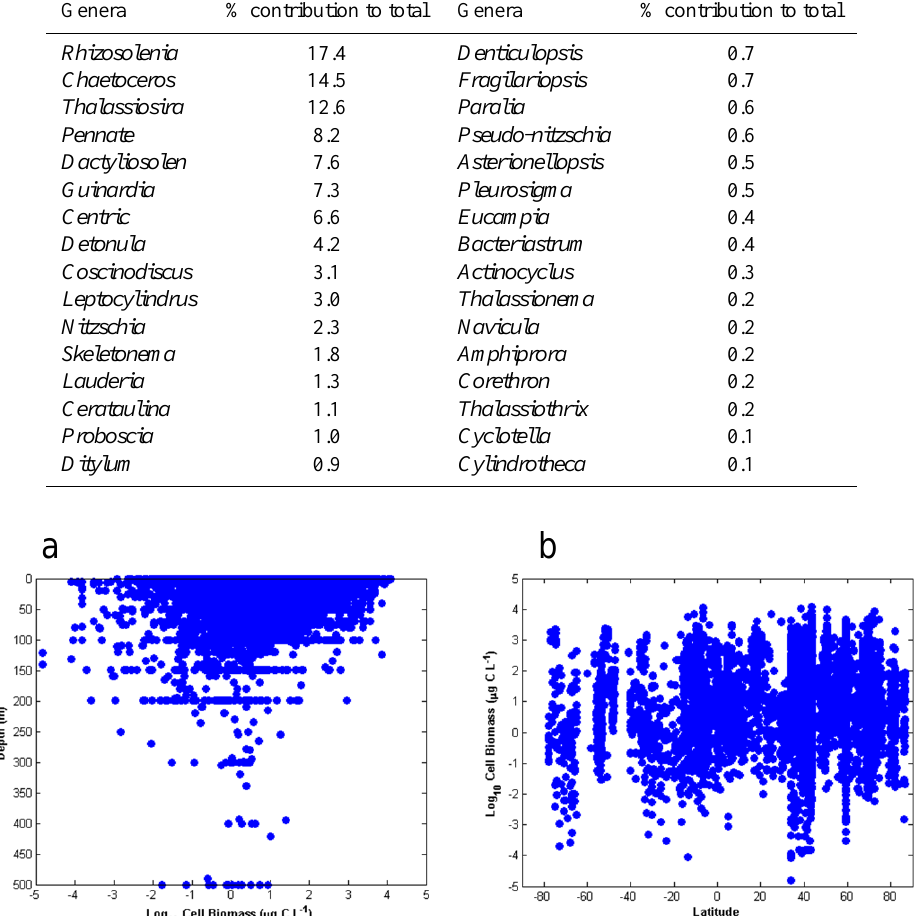
Table 2. Diatom genera in ascending order of contribution to total biomass. 32 genera amount to 99% of global biomass. Note that uniden- tified pennate and centric diatoms represent a non-negligible 14.8% of the total biomass. If they were identified down to genera, the order of dominance for the most abundant groups might change.